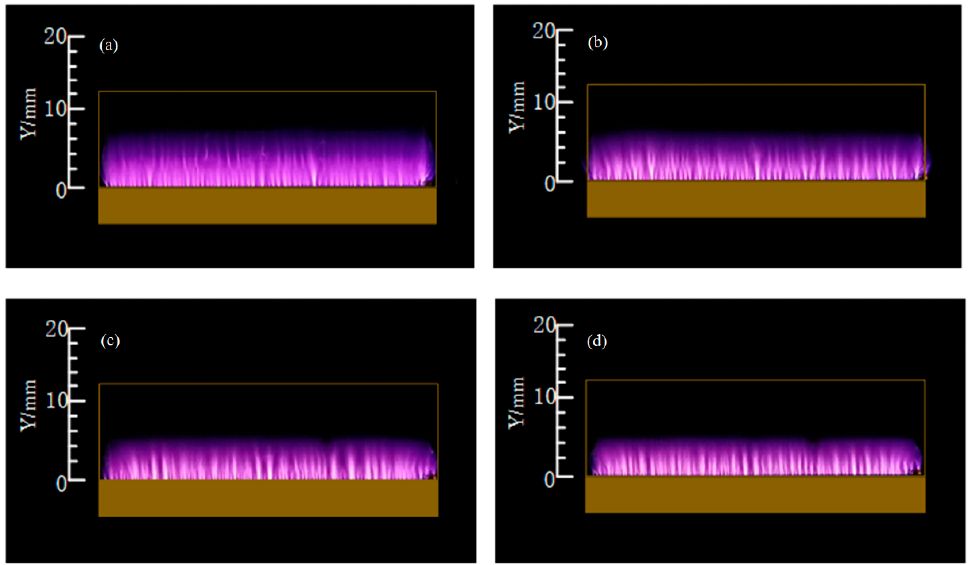
Figure 8. Discharge images of nanosecond-pulsed dielectric-barrier discharge at different pressures ( a ) 40 kPa, ( b ) 50 kPa, ( c ) 60 kPa, ( d ) 70 kPa.